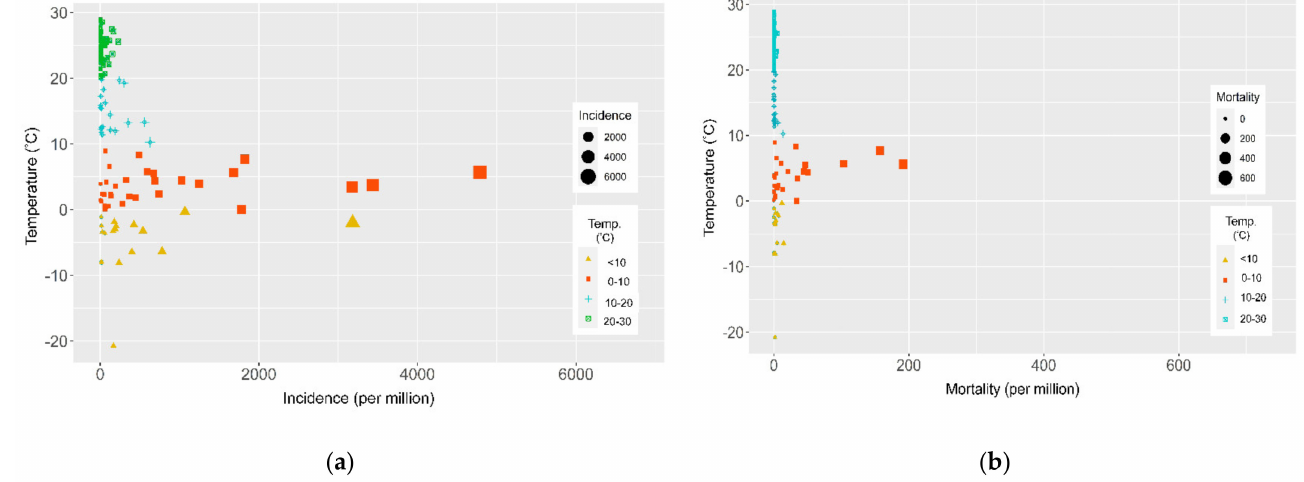
Figure 1. Scatterplot showing the relationship between average annual temperature (°C) and ( a ) incidence (per million) and ( b ) mortality (per million) of SARS-CoV-2. Table 1. Characteristics by the epidemic status of the study countries. Characteristics